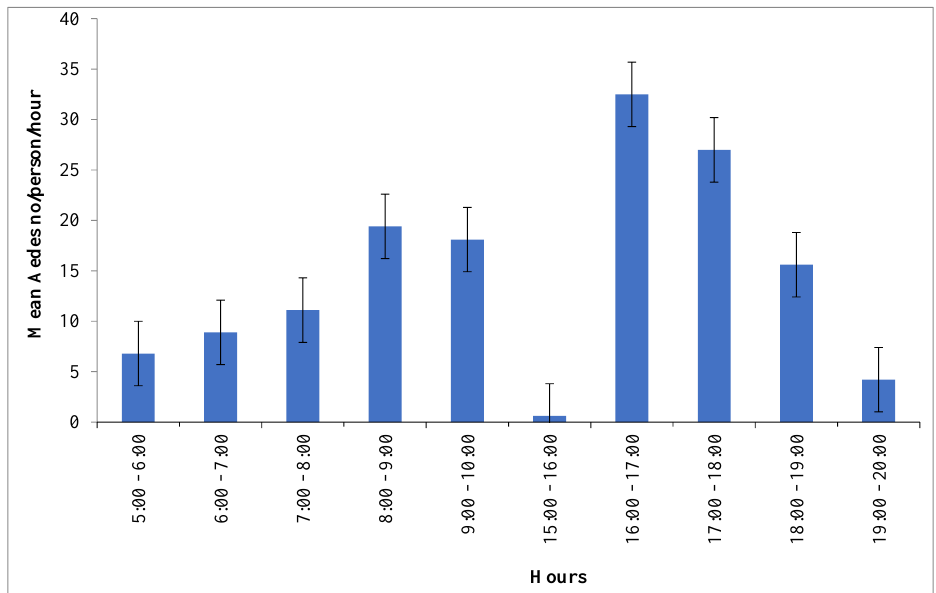
Figure 3. Overall hourly biting activity of Ae. simpsoni complex/person/h in Boko Dawula and Ofa districts, southwest Ethiopia . The Ae. simpsoni complex is consistently active, with a similar pattern outdoors within the villages and inside the forests. The peak human-biting activity of Ae. simpsoni is observed outdoors, averaging 10.6 bites/person/h in Ofa and 6.3 bites/person/h in Boko Dawula from 16:00 – 17:00 h. Morning peak human-biting activity in the forest is observed from 8 to 10 am in both Ofa and Boko Dawula. The highest biting peak of Ae. simpsoni complex in the forest is observed between 16:00 and 17:00 h (13.4/person/h) in Boko Dawula. The peak biting times of Aedes is also relatively observed in open land (Figure 4).